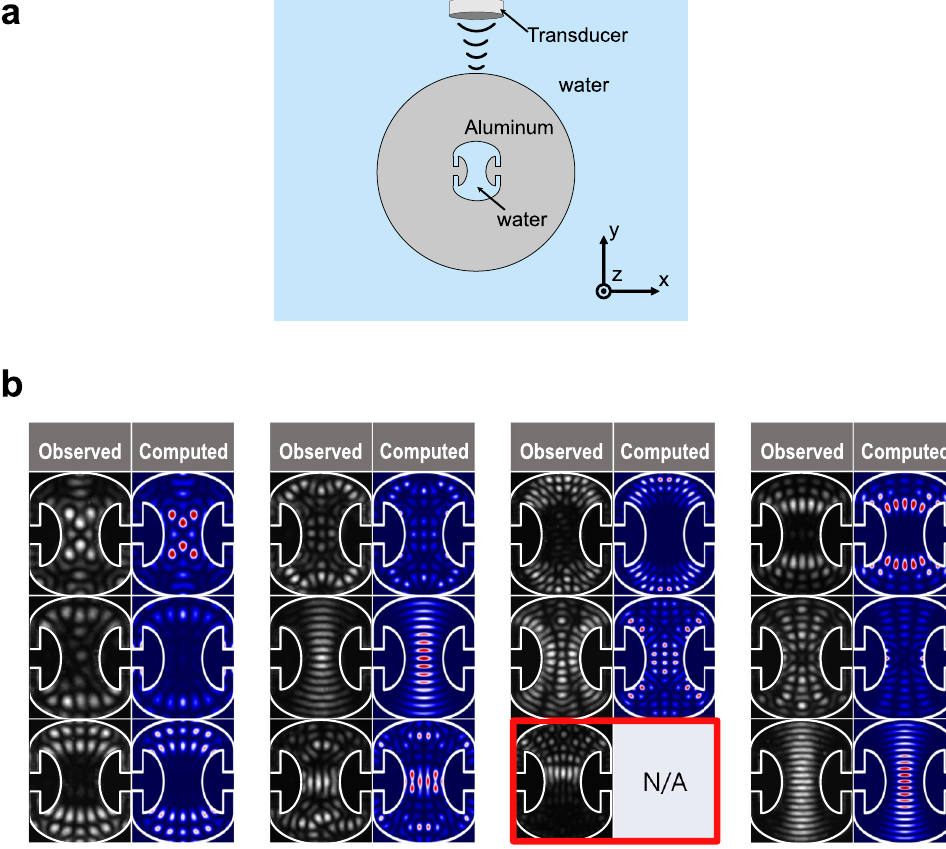
Figure 2. Comparison of observed mode patterns with computed ones. ( a ) Mode excitation arrangement. The gray shaded region is aluminum and light blue shaded regions correspond to water. ( b ) Images of the experimentally observed acoustic resonant modes compared with numerically computed ones. The resonant frequencies range from (771.3 ± 0.1) kHz to (1262.3 ± 0.3) kHz and their Q factors vary from 290 ± 30 to 1000 ± 100. Among the observed modes, an HIM is highlighted with red